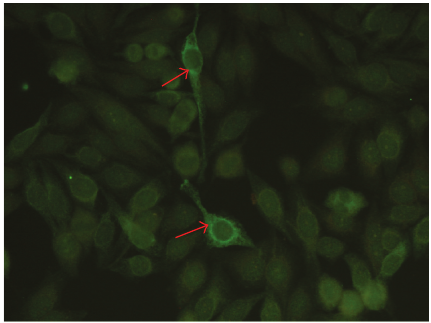
Figure 4: Putative indirect immunofluorescence pattern on HEp-2 cells. A serum sample from a patient with anti-HMGCR antibodies wasusedtostainHEp-2cells.Onthesecells,thefluorescencepattern suggestive for anti-HMGCR is a finely granular cytoplasmic staining on a minority (3% or less) of HEp-2000 cells with perinuclear